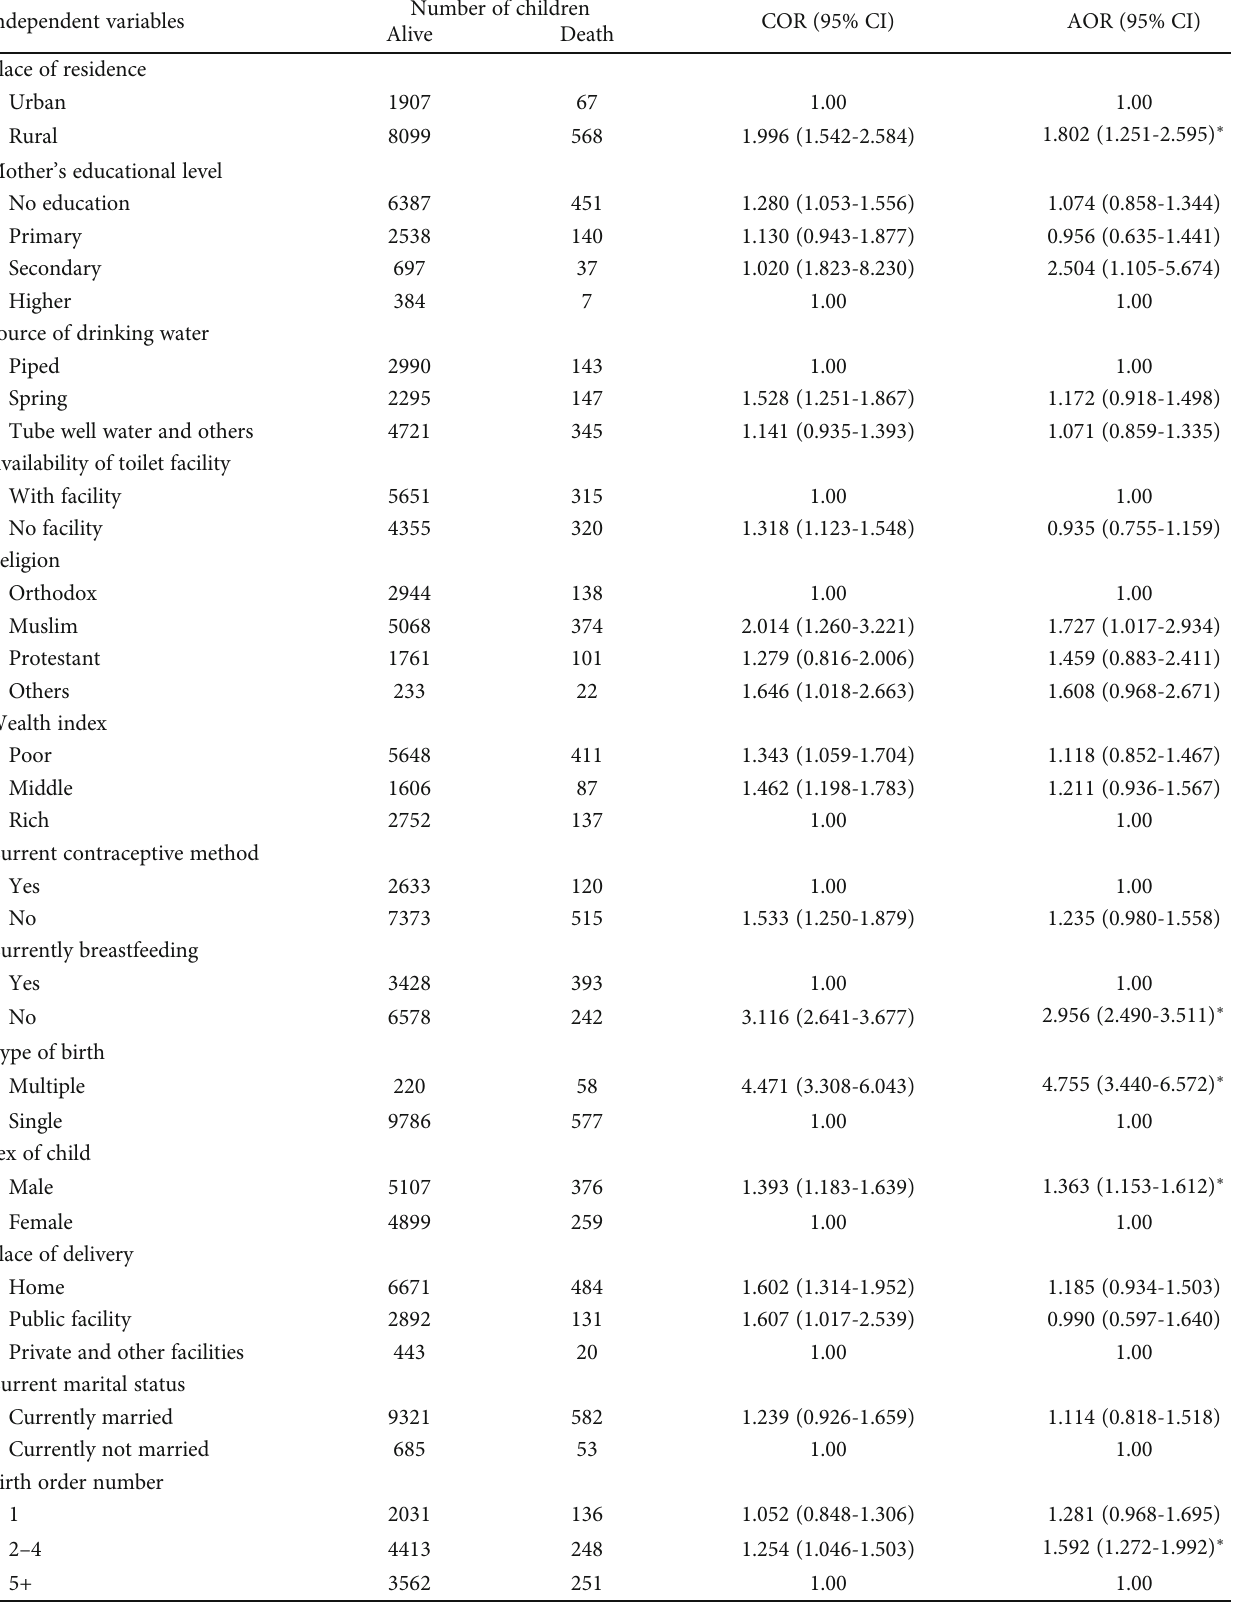
Table 3: Bivariate and multivariable analyses of variables associated with U5CM in Ethiopia based on EDHS,